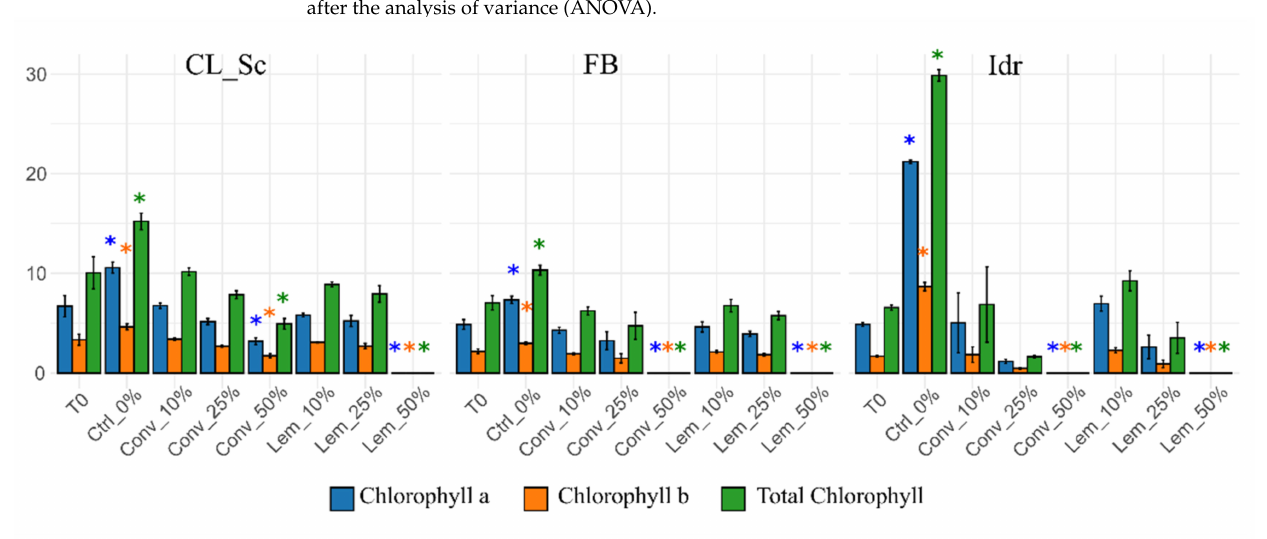
Figure 2. Pigment contents of the second experiment; asterisks indicate statistically significant differences between tests and the pigment content of T0 (the microalgal culture at the beginning of the experiment). “Conv” samples: vegetation water obtained with traditional method; “Lem” samples: vegetation water obtained with lemon peels extraction. Ctrl_0% samples: only TAP